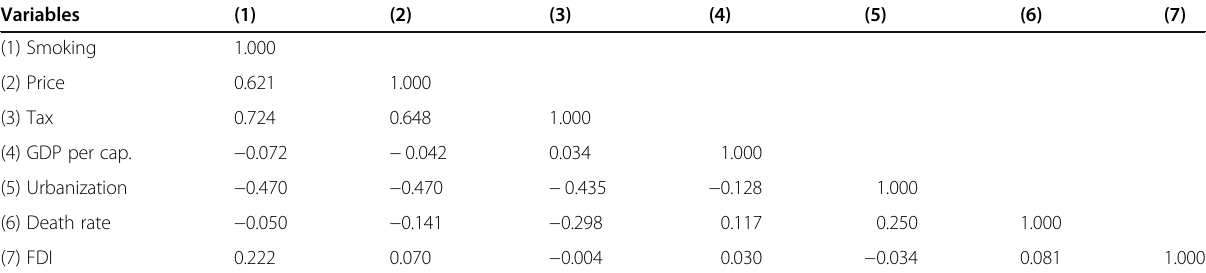
Table 4 Matrix of correlations of the prevalence of smoking, tobacco price, tobacco tax and control variables (2010 – 2016)